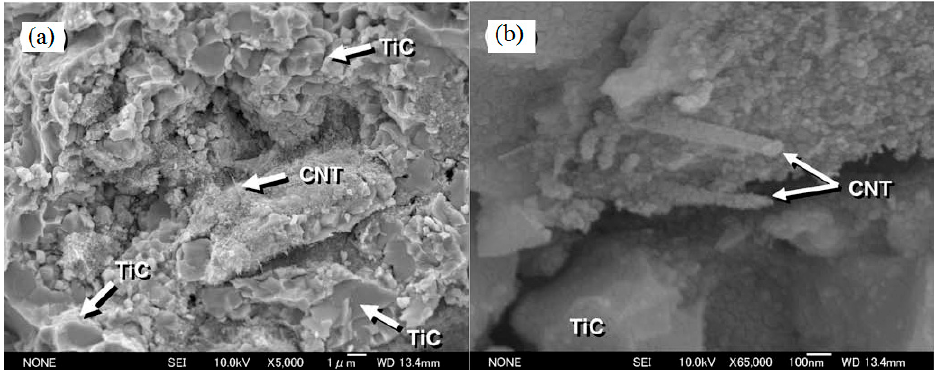
Figure 19. SEM image of fracture surface of CNT-Ti nanocomposites in different magnifications [140]: ( a ) ×5000; ( b ) ×65,000. (Adapted with permission from [140], Elsevier, 2009.) ( a ) × 5000; ( b ) × 65,000 (Adapted with permission from [140], Elsevier, (c) CNT-Reinforced Mg Matrix Nanocomposites